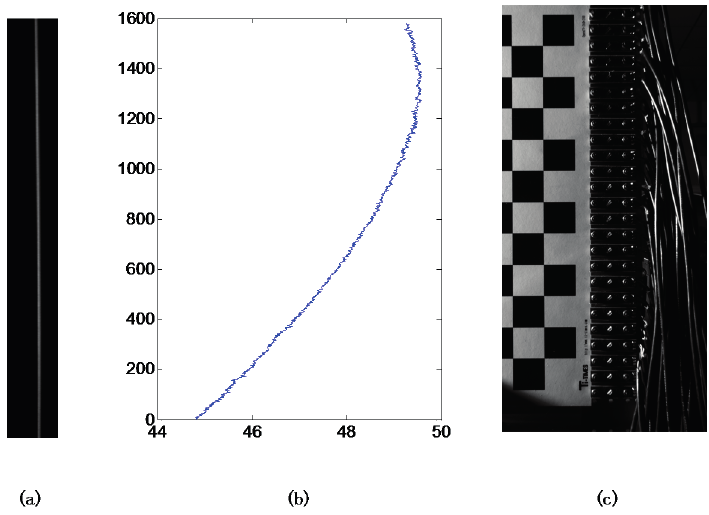
Figure 8. The line images captured by the CCD camera. ( a ) Image captured by the camera; and ( b ) Line pattern center extraction result of all the image rows (Unit: pixel); ( c ) Image of the checkerboard calibration